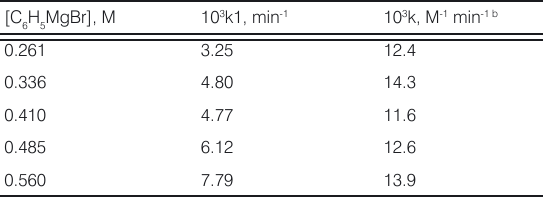
Table 1. Effect of phenylmagnesium bromide ( 1a ) concentration on the reaction rate of phenyl magnesium bromide ( 1a ) with phenyl tosylate ( 2 ) in THF: toluene (7:10) at 90 o C. a